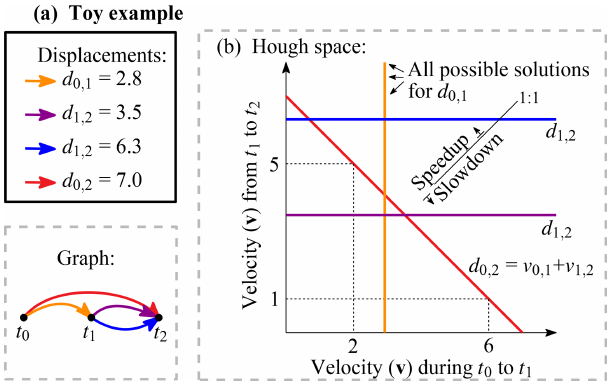
Figure 3. On the left is a graphical representation of Landsat 8 ac- quisitions at different times ( t ) illustrated as nodes and matching solutions with displacements ( d ) are shown as edges, within a net- work. The subscript for the displacement denotes the time interval. The velocities ( v ) are estimated through the collection of all these displacements. On the right the mathematical representation or its parameter (Hough) space for voting of displacements over two time instances is shown; in this case the parameter space of only v 0 , 1 and v 1 , 2 are